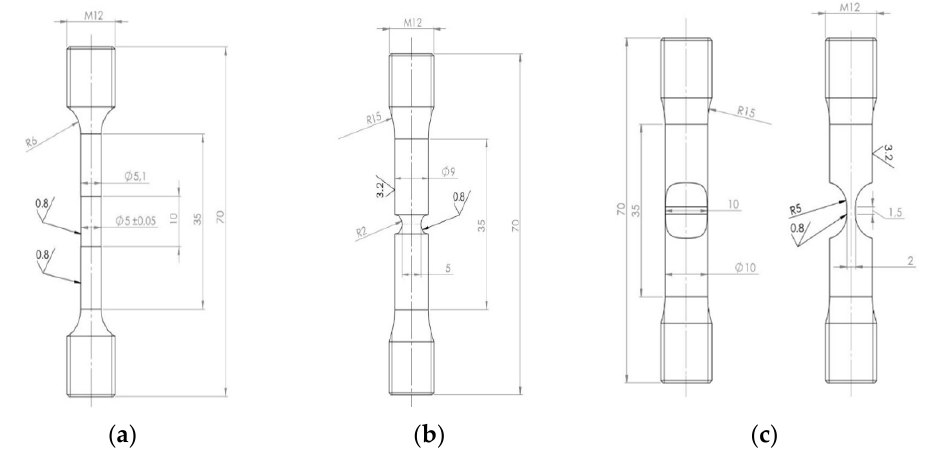
Figure 5. Specimen geometries: ( a ) round bar; ( b ) round notched bar; ( c ) plane strain.